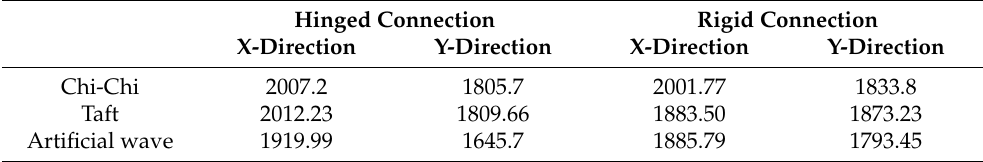
Table 13. Peak base shear under the action of rare earthquakes